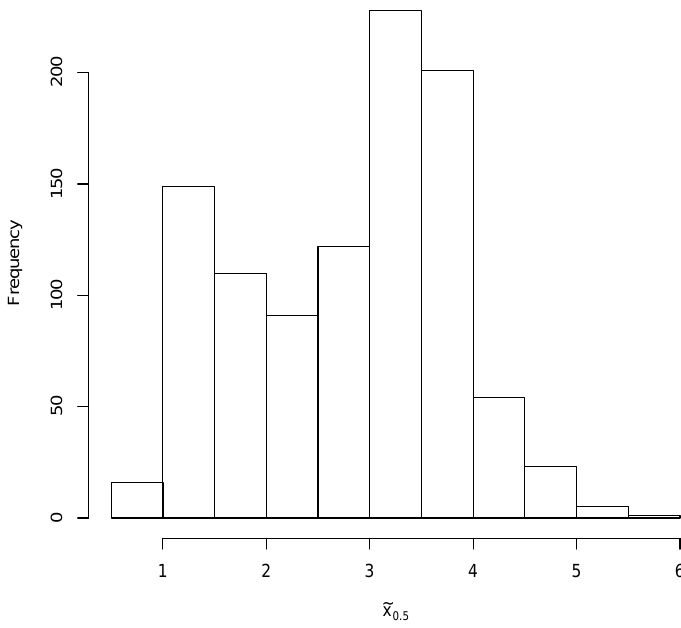
Figure 13. The histogram of 10,000 Markov chains of ˜ x 0.5